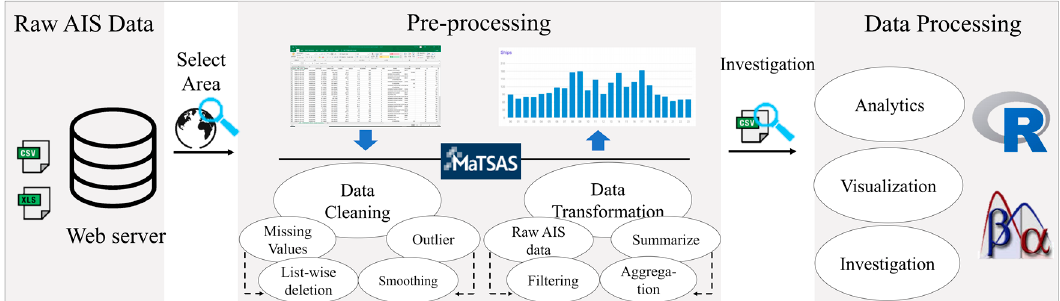
Figure 2. Overview of data preprocessing and processing method. J. Mar. Sci. Eng. 2020 , 8 , x FOR PEER REVIEW